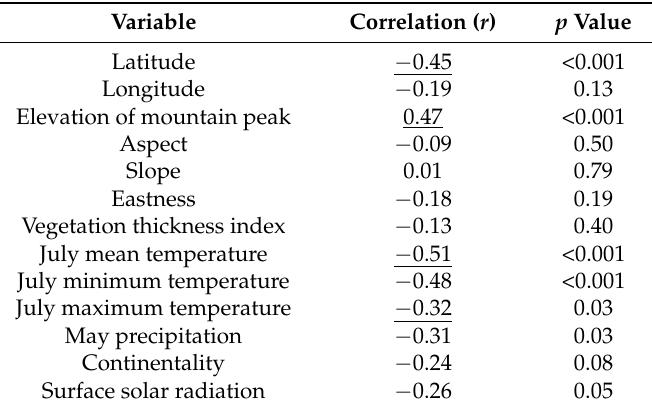
Table 1. Pearson correlation coefficients obtained by relating treeline elevation and different variables for sites located in the Tibetan Plateau ( n = 57 treelines).